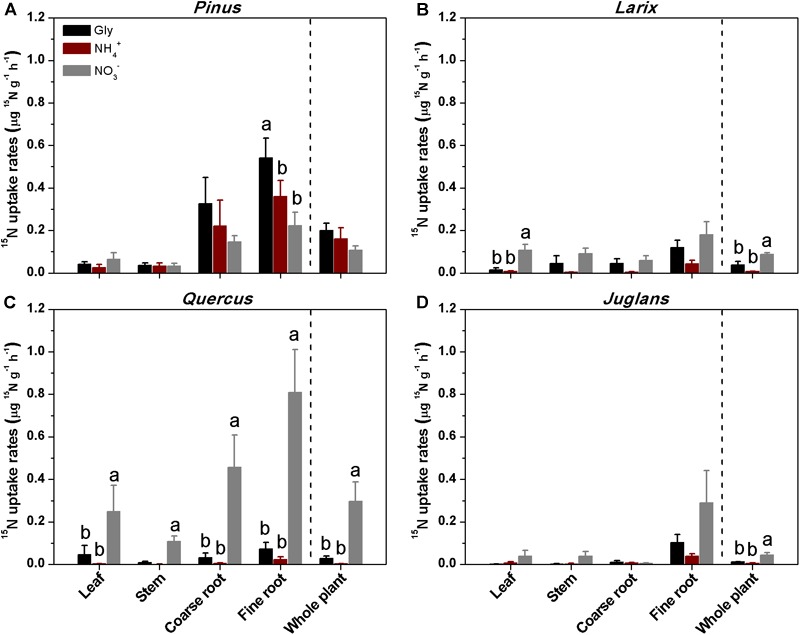
Mean (± 1 SE, n = 4) uptake rates of 15N by different plant organs and whole plants of the four taxa (A–D) at 48 h after soil injection of 15N as glycine, ammonium, or nitrate. Different letters above the bars indicate significant differences in uptake rates between N forms for each species (one-way ANOVA, P < 0.05).